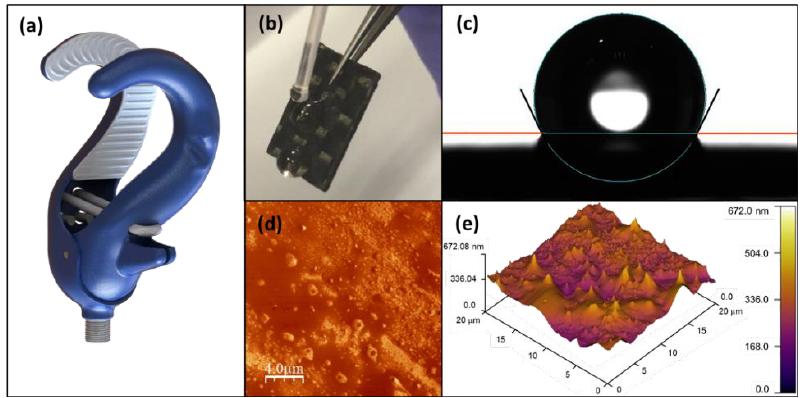
Figure 11. Surface properties of chemically treated carbon fiber: ( a ) carbon fiber material (blue) covered with hydrophobic polyester resin; ( b ) water repellence observed by depositing droplets on the surface; ( c ) characteristic image of a droplet with contact angles marked; ( d , e ) AFM images (2D and 3D representations, respectively) of the treated carbon fiber, showing details of surface relief and roughness.